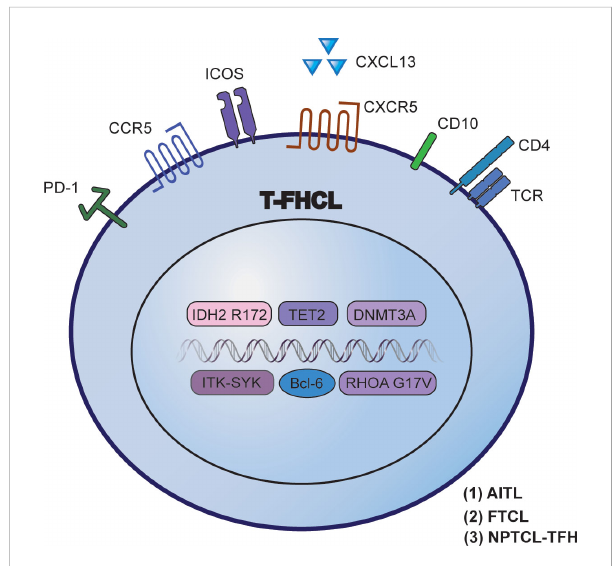
FIGURE 1 Characteristic biomarkers and genetic aberrations in T-FHCL. Identi fi cation of Tfh markers, epigenetic mutations and other speci fi c aberrations aids the precise diagnosis of T-FHCL at the molecular